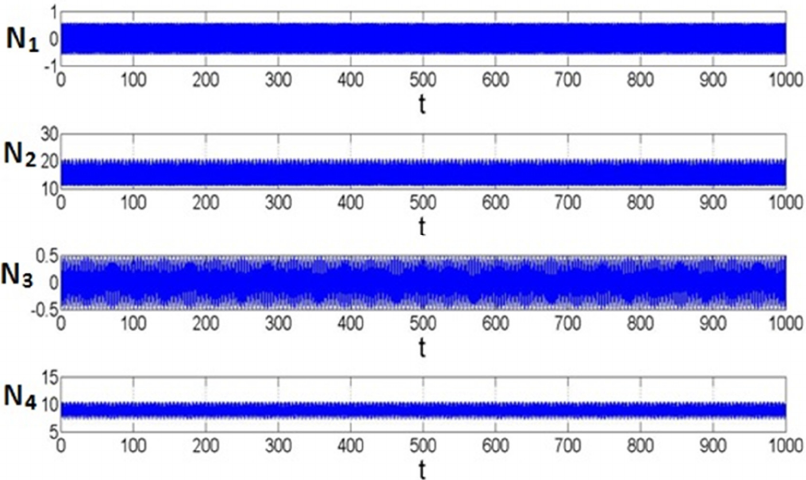
Figure 2. Time series for the nonlinear terms groups N 1 , N 2 , N 3 and N 4